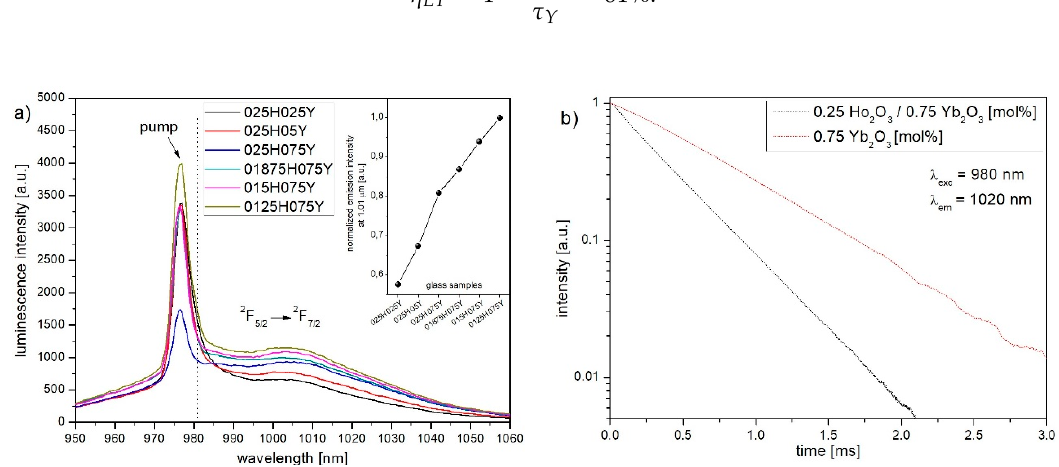
Figure 7. ( a ) Emission spectrum in 1.01 µm band and ( b ) single exponential luminescence decay curves of Yb 3+ : 2 F 5/2 state in glasses doped with Yb 3+ and co-doped with Ho 3+ /Yb 3+ ions.